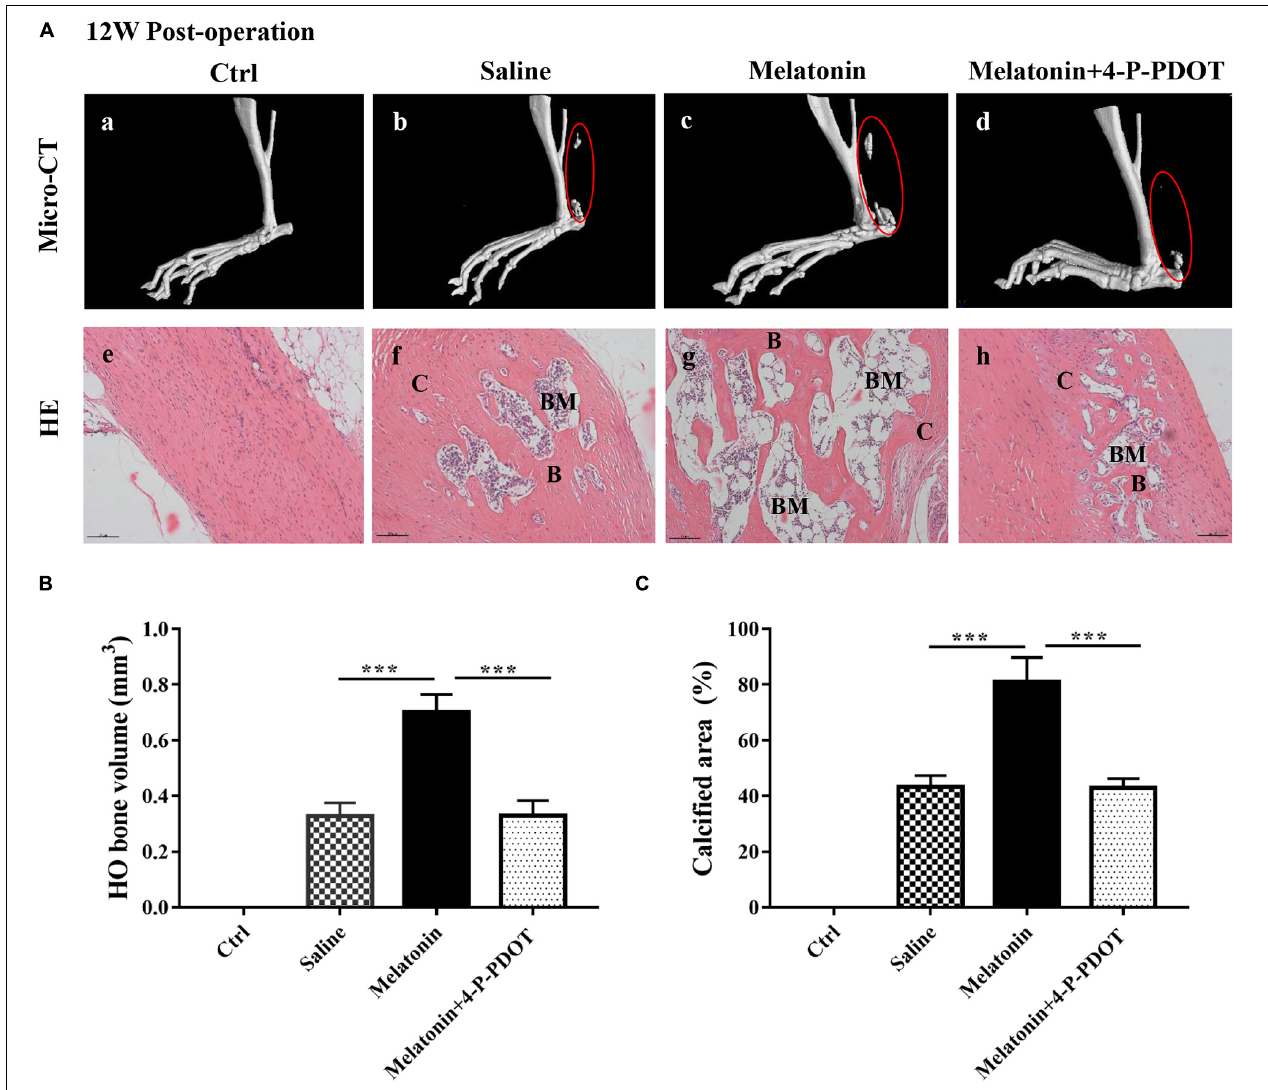
FIGURE 3 | Effect of the melatonin-MT2 pathway on HO formation in injured Achilles tendons. (A) Micro-CT scans of HO formation in specimens from Achilles tendons from normal rats (a) , saline-treated rats (b) , melatonin-treated rats (c) , and melatonin- and 4-P-PDOT-treated rats (d) at 12 weeks after the operation. HE staining of normal and injured Achilles tendons and heterotopic ossification from the different groups mentioned above. B, bone; BM, bone marrow; C, cartilage, black arrows: blood vessels, black triangles: chondrocytes. The dashed line of the SOFG-stained sections shows the newly formed heterotopic bone. Scale bar, 100 µ m. (B) HO volume (mm 3 ) at injured Achilles tendons at 12 weeks. (C) Quantitative histological analyses of the proportions (%) of calcified areas at injured Achilles tendons at 12 weeks. The data represent the mean ± SD. *** P < 0.001 versus the saline control group or the melatonin